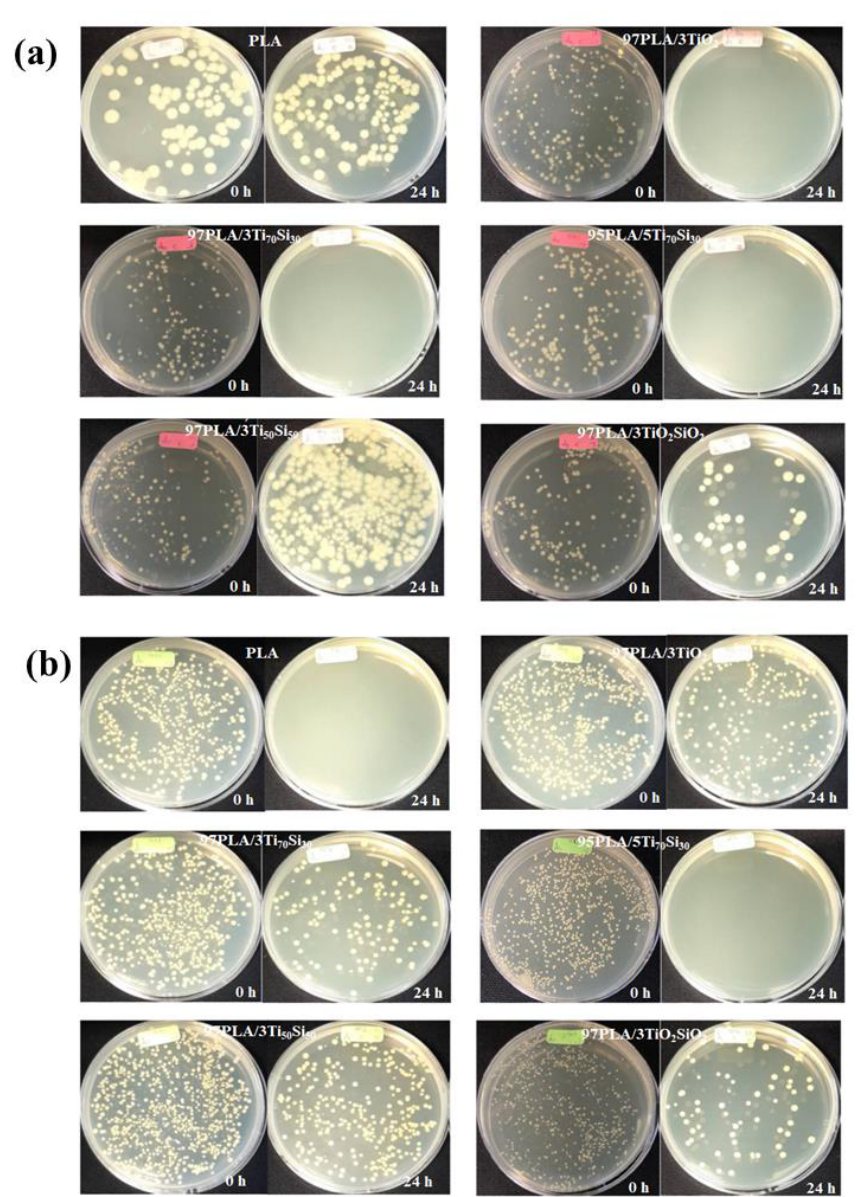
Figure 12. The number of ( a ) bacteria Escherichia coli and ( b ) bacteria Staphylococcus aureus on PLA and PLA composite films at time 0 h (at dilution 10 −3 ) and 24 h (at dilution 10 0